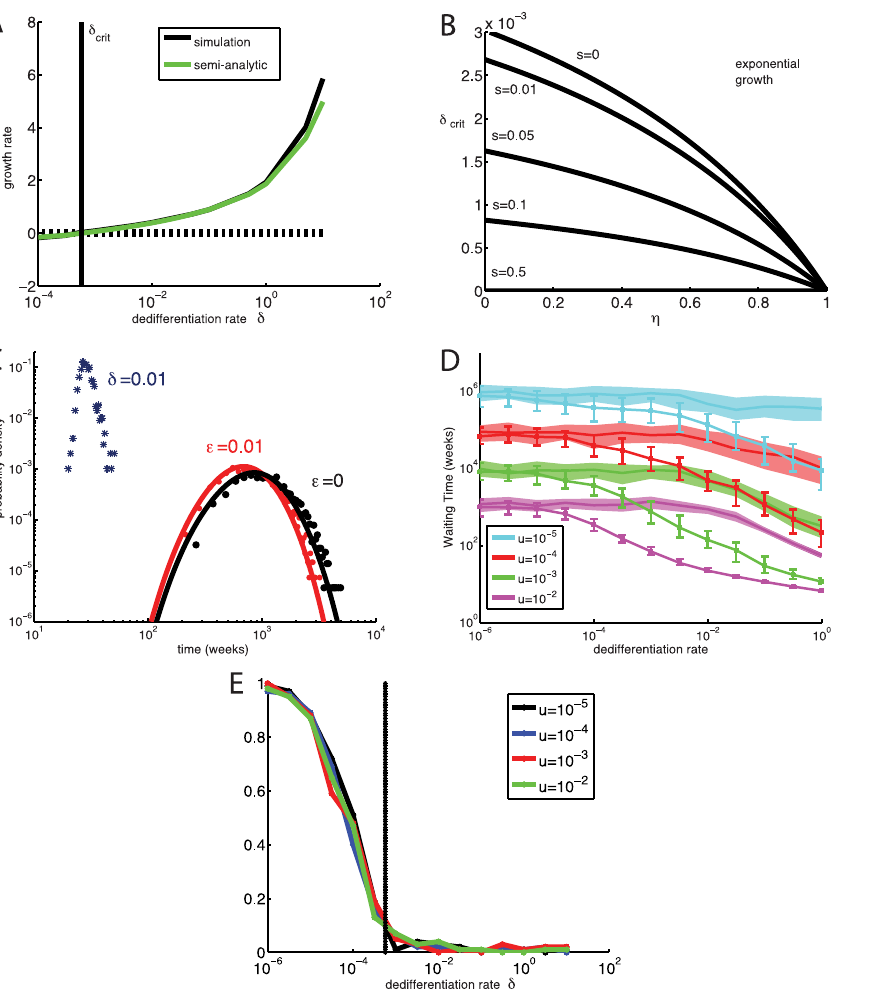
Figure 6. Fixation and exponential growth of two-mutation cells with dedifferentiation for variable stem cell population size. A: Observed growth rate k of the stem cell population (black curve) and the semi-analytic approximation Eq. (18) (green) for g ~ 0 , j ~ 1 , and u ~ 0 : 01 . The vertical line denotes d crit . B: Analytically predicted critical dedifferentiation rate d crit as a function of asymmetric division probability g and the growth advantage s of the two-mutation progenitor population. Exponential growth occurs for d w d crit . C: Normalized histogram (stars) of waiting times for exponential growth of the stem cell population with stochastic homeostasis and dedifferentiation for u ~ 0 : 01 , d ~ 0 : 01 . For comparison the histogram (red and black dots) as well as the analytical distributions of times to fixation given strict homeostasis for e ~ 0 : 01 and e ~ 0 are also shown. D: The median and inter-quantile range of times to first occurrence of N sc ~ 100 two-mutation stem cells, given stochastic homeostasis and a range of dedifferentiation rates d . For comparison, the waiting times to fixation for N sc ~ 100 given strict homeostasis (shaded areas) for the equivalent value of e are also shown. E: The probability that the first two-mutation stem cell arose from mutation in the stem cell compartment, rather than dedifferentiation. Vertical line denotes d crit . Parameters for all simulations given in Table